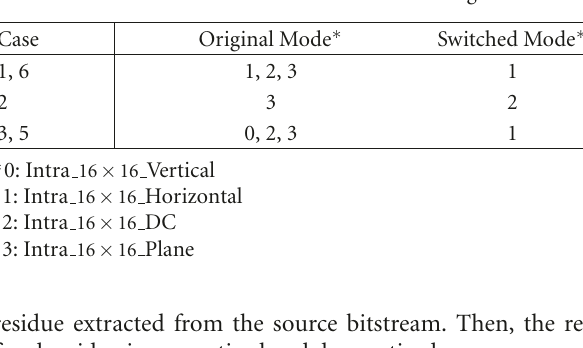
Table 3: Cases of Intra16 mode